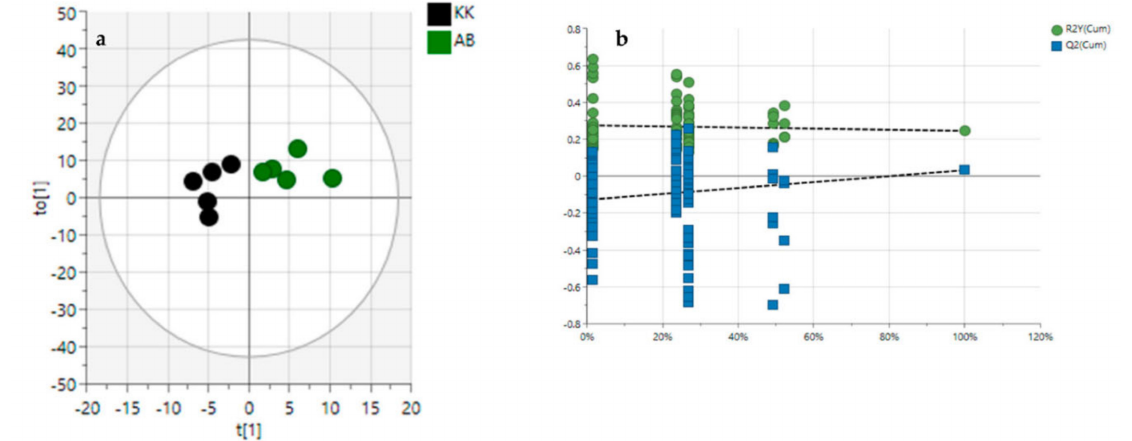
Figure 4. Orthogonal partial least squares discriminant analysis (OPLS-DA) ( a ), permutation tests, ( b ) in ESI − mode. AB—Abraka; KK—Kokori.